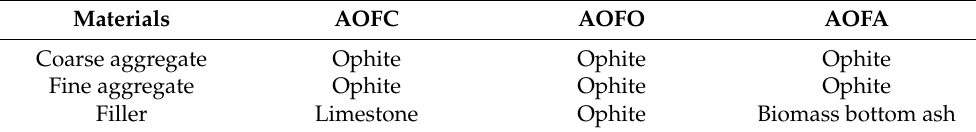
Table 4. Materials conforming the different bituminous mixtures developed.